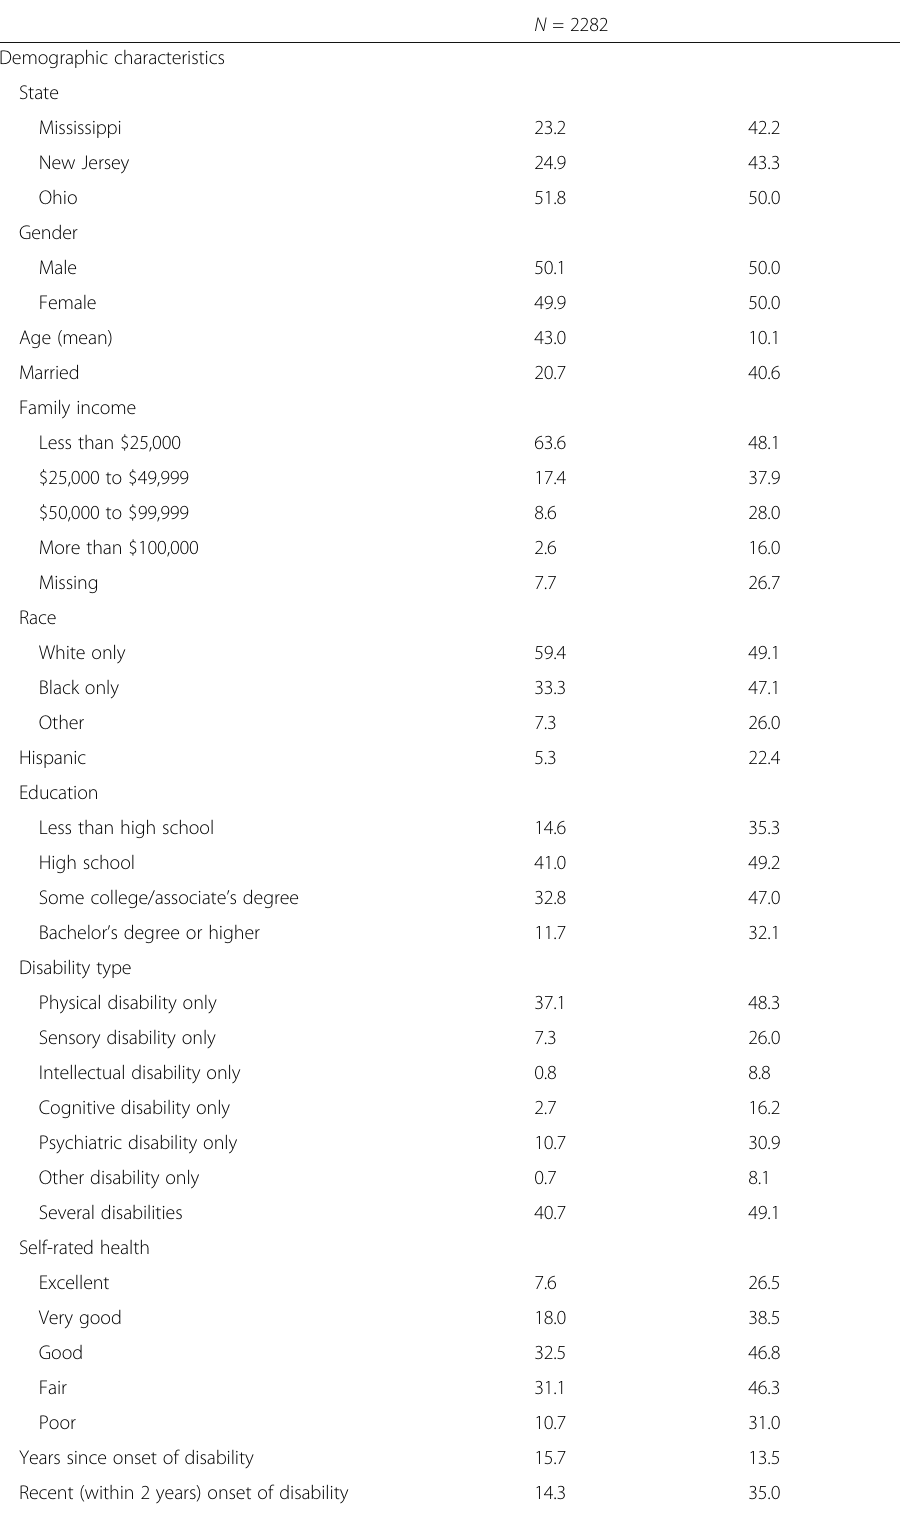
Table 2 Descriptive statistics of SDE